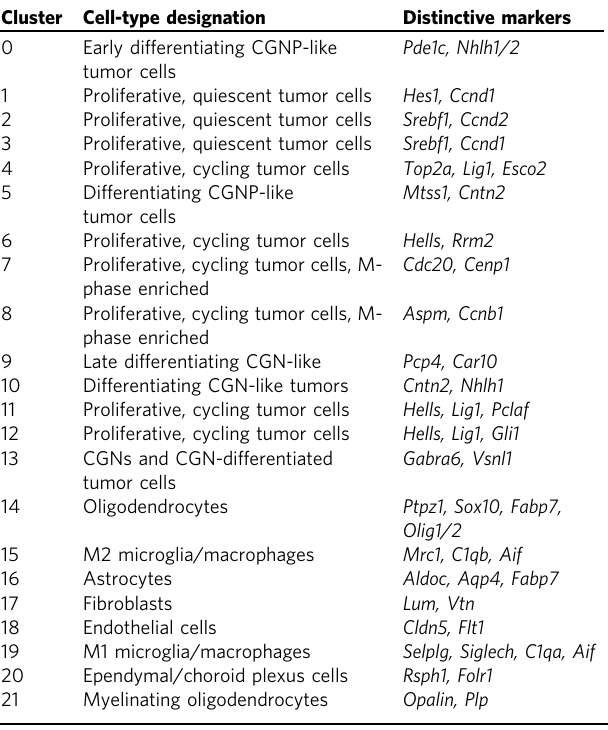
Table 1 Identi fi cation of clusters as speci fi c types of tumor and stromal